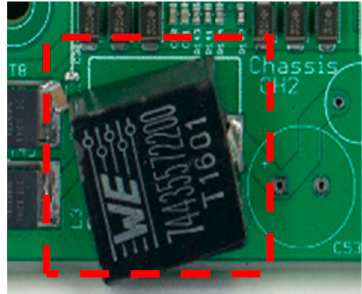
Figure 1. Sample for moving passive component after soldering.